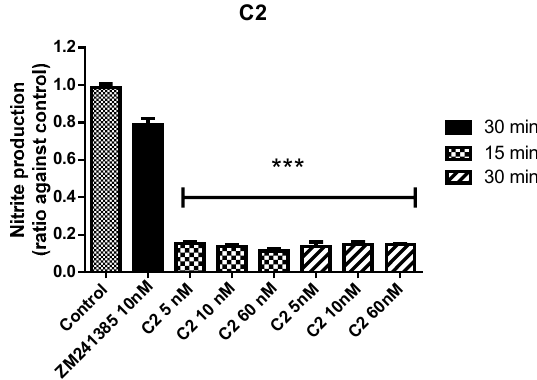
Figure 9. Antioxidant effects of ZM241385 and C 2 on mixed glial cell culture. Ratio of NO 2 ¯ production after treatments. Results represent the average of 3–5 independent experiments. *** p < 0.001 of treated cells against control.